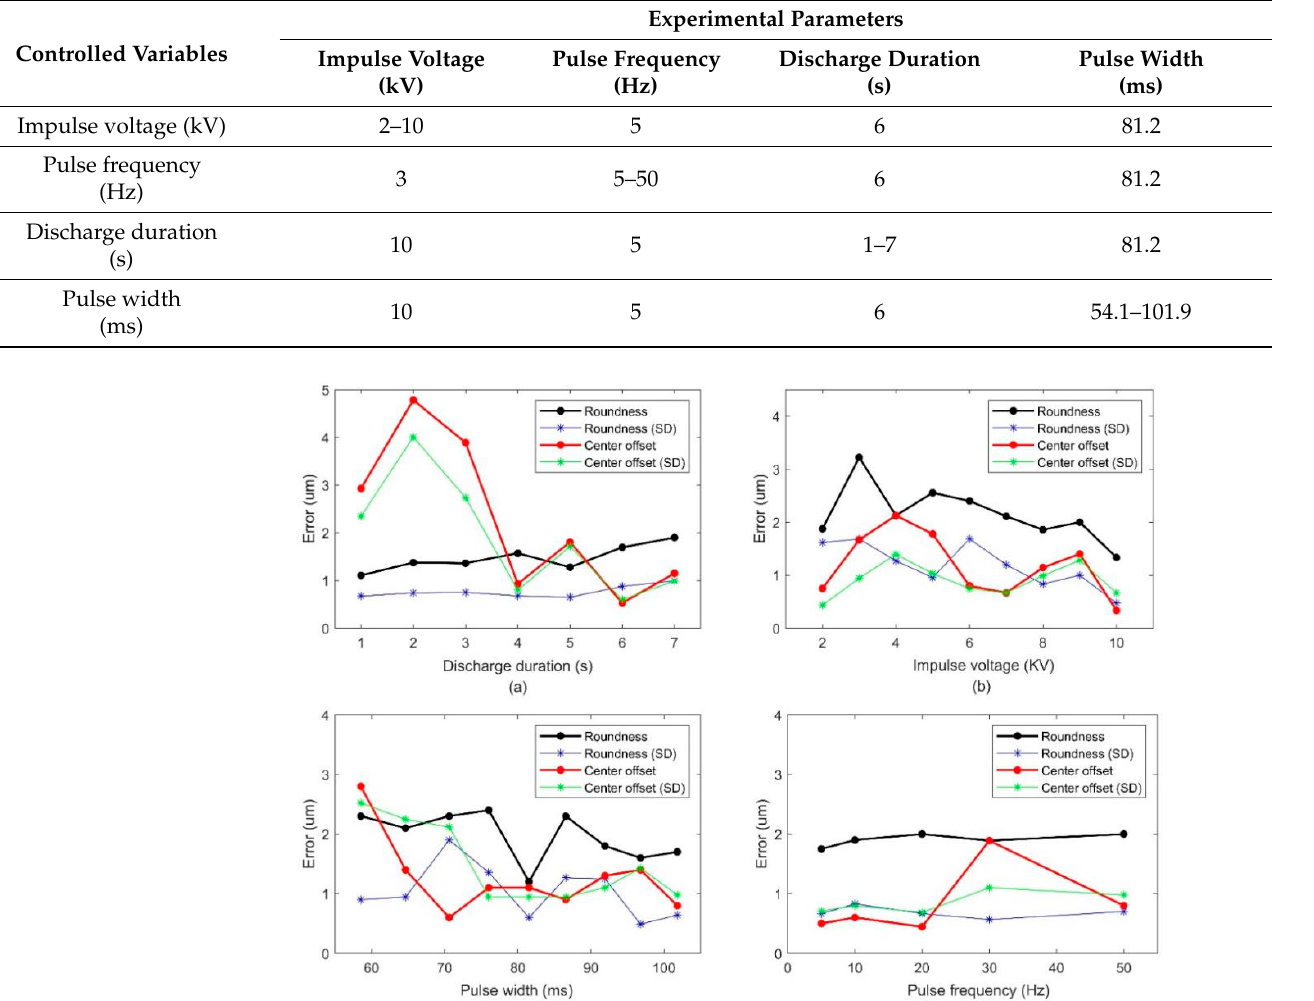
Table 1. Experimental parameters of each group control variable experiment.